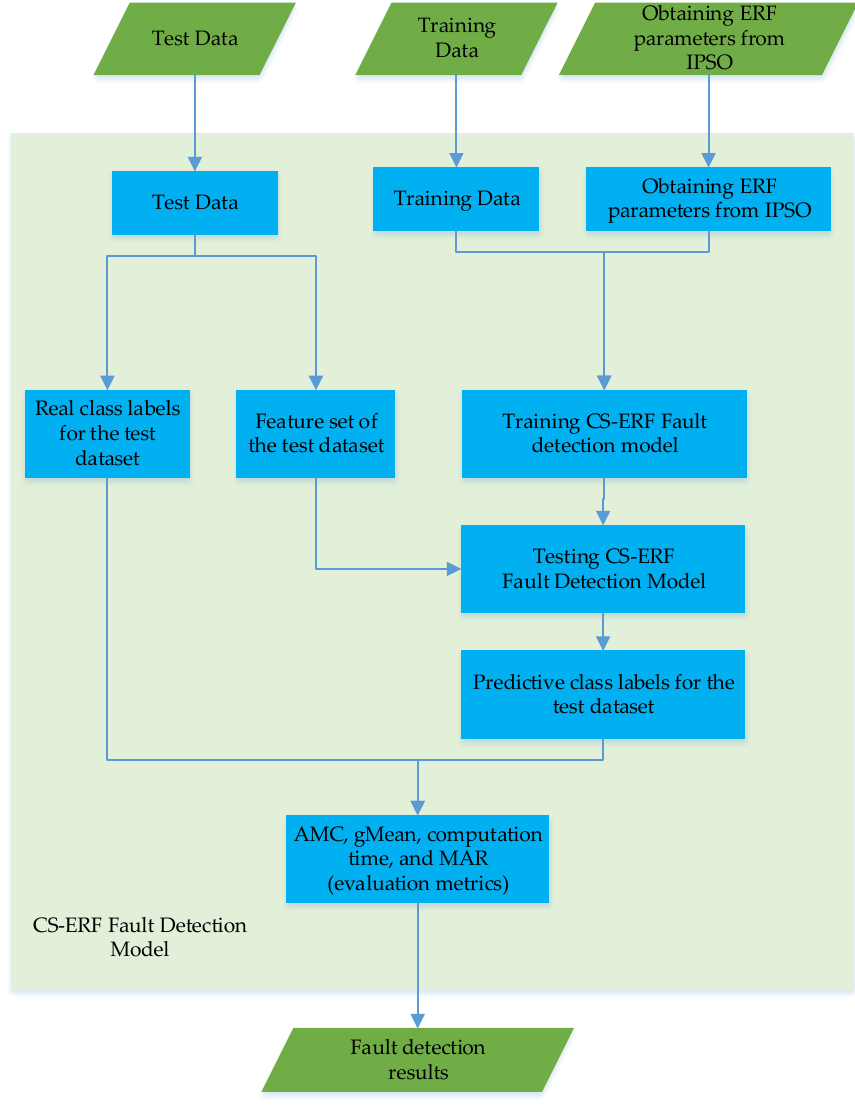
Figure 4. CS-ERF fault detection model generation process.